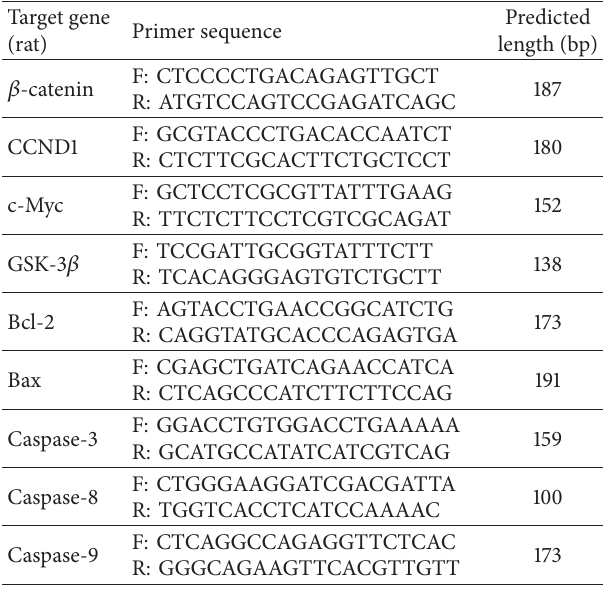
Table 1: Primers used for